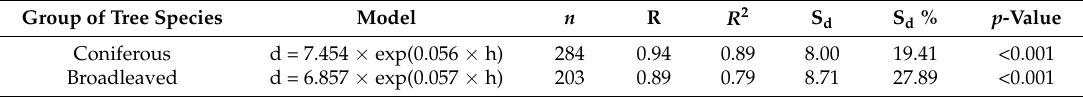
Table 2. Regression models used for derivation of tree diameter based on tree